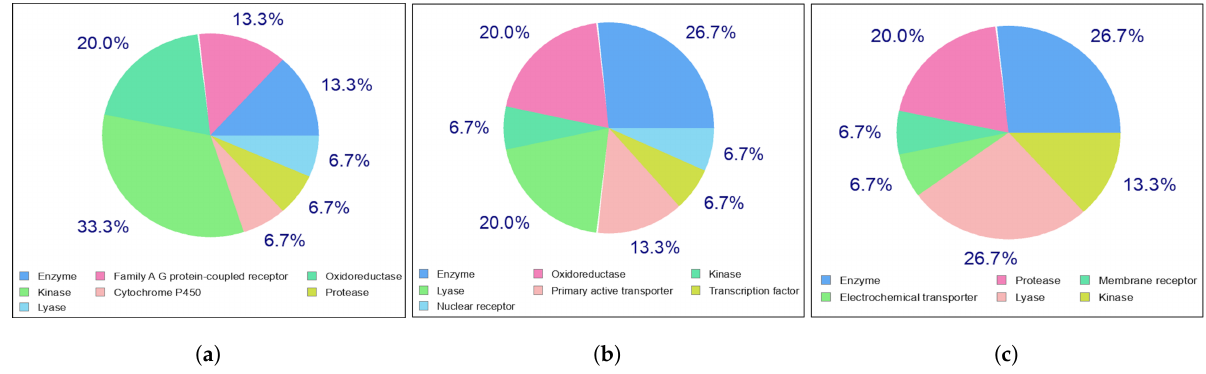
Figure 8. Potential top 15 target classes for ( a ) Quercetin, ( b ) Kaempferol, and ( c ) Chlorogenic acid.